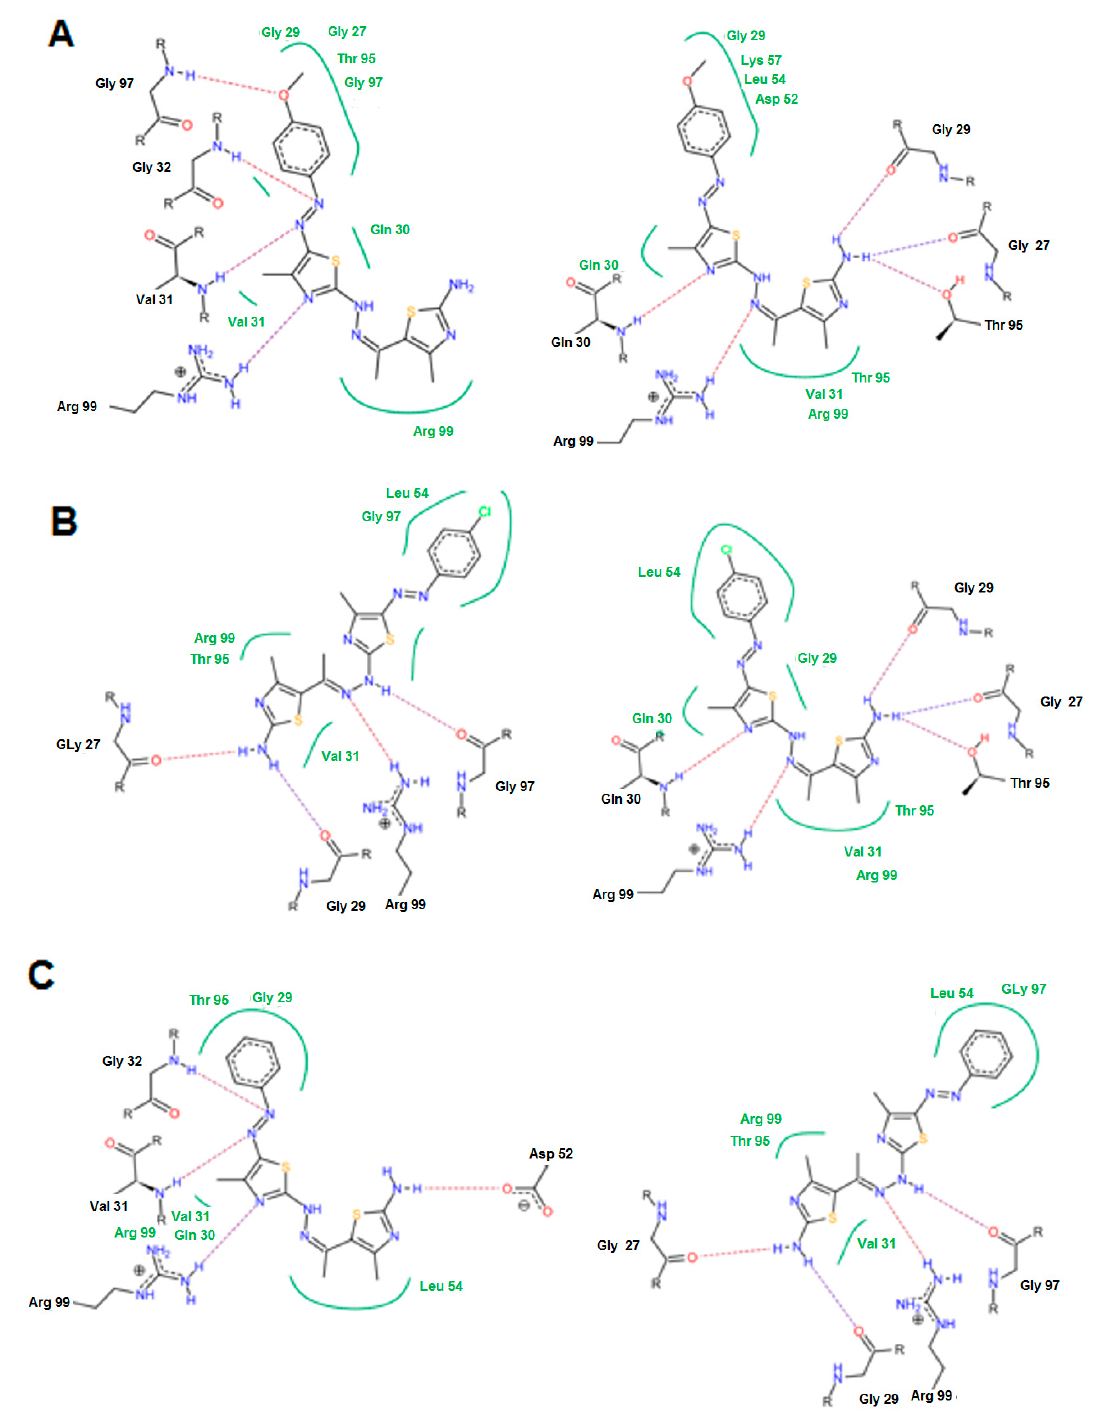
Figure 7. Possible binding modes of compounds ( A ) 14e ; ( B ) 14c ; and ( C ) 14a .